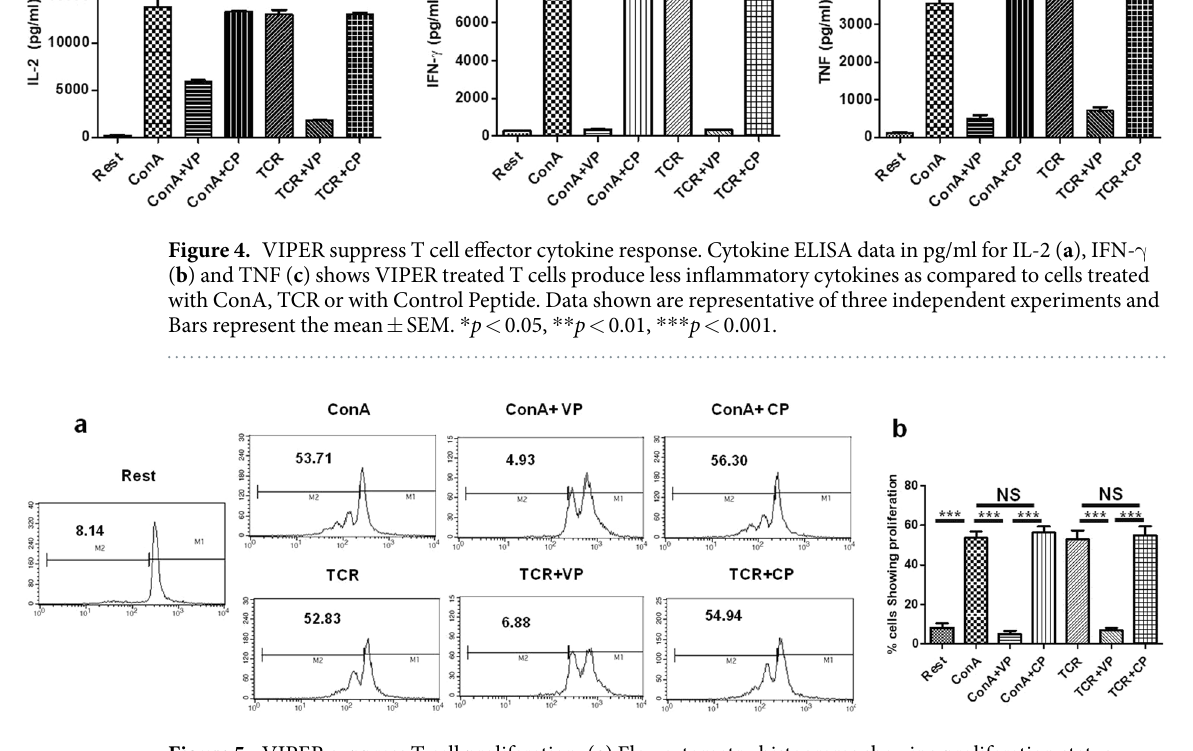
Figure 5. VIPER suppress T cell proliferation. ( a ) Flowcytometry histograms showing proliferation status of purified T cells from BALB/c mice which are untreated or stimulated with ConA, ConA + VIPER, ConA + Control Peptide, TCR, TCR + VIPER and TCR + CP respectively. ( b ) Bar diagram showing %